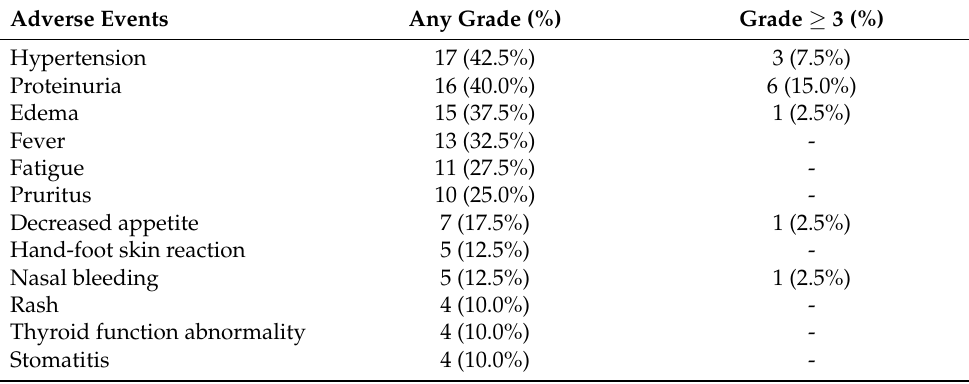
Table 2. Adverse events during the follow-up period